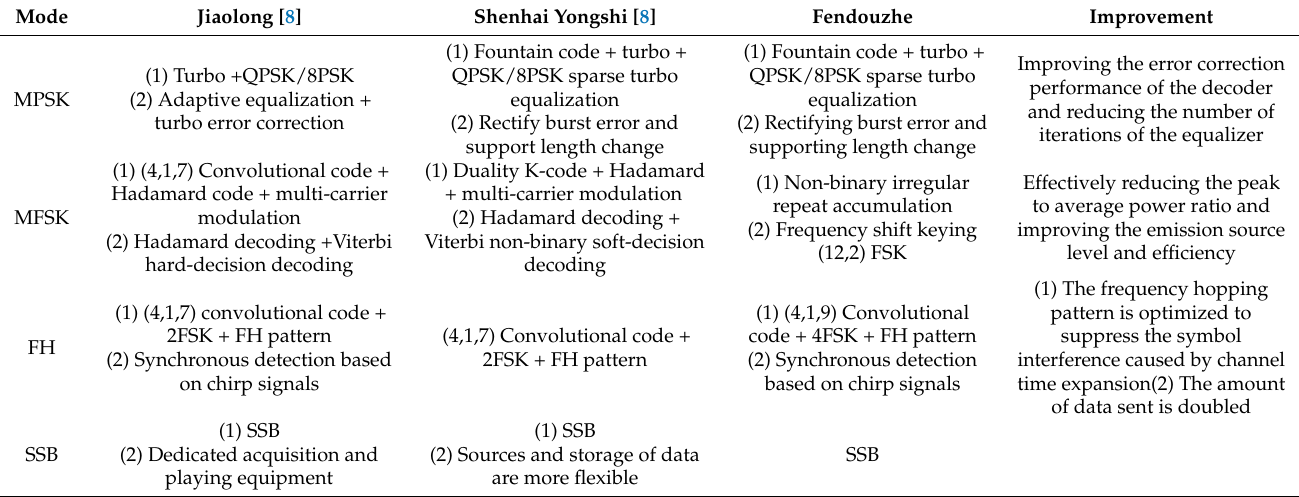
Table 2. Improvements in the signal processing